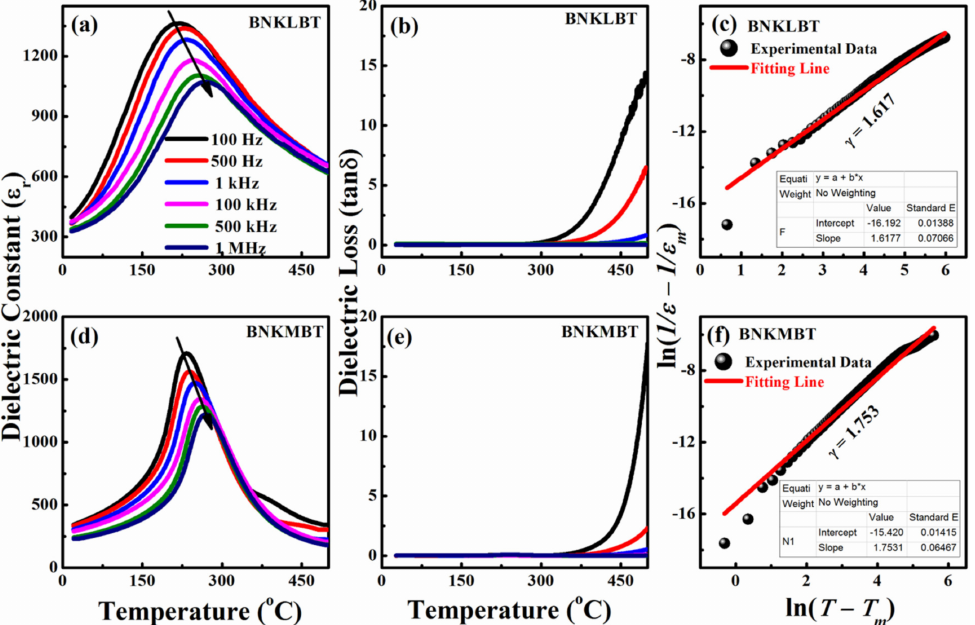
Figure 4. Temperature-dependent dielectric constant ( ε r ) of ( a ) the BNKLBT ceramic, and ( d ) the BNKMBT ceramic. Temperature-dependent dielectric loss (tan δ ) of ( b ) the BNKLBT ceramic and ( e ) the BNKMBT ceramic. Diffusion coefficient ( γ ) measurements by (1/ ε − 1/ ε m ) vs. (1/T − 1/T m ) plots of ( c ) the BNKLBT ceramic, and ( f ) the BNKMBT